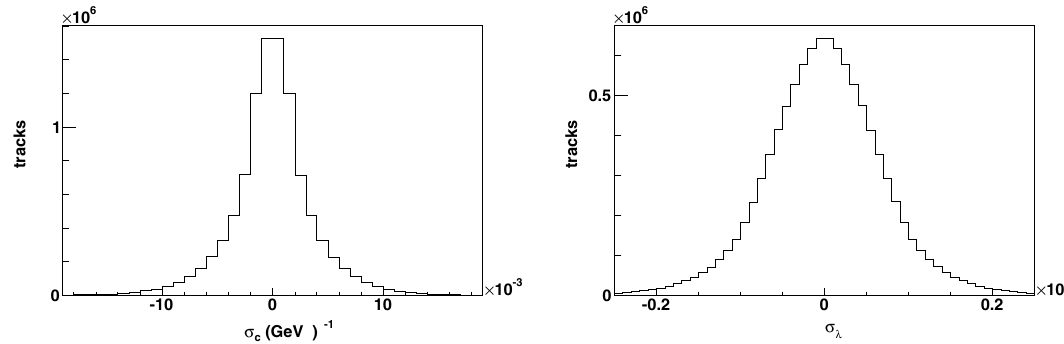
Figure 10. Distribution of (left) the difference of q / p T between the reconstructed and true particle, yielding a 3.7 TeV − 1 , and (right) the difference of (cid:31) between the reconstructed and true particle, curvature resolution σ c = yielding a resolution on the cotangent of the polar angle σ (cid:31)